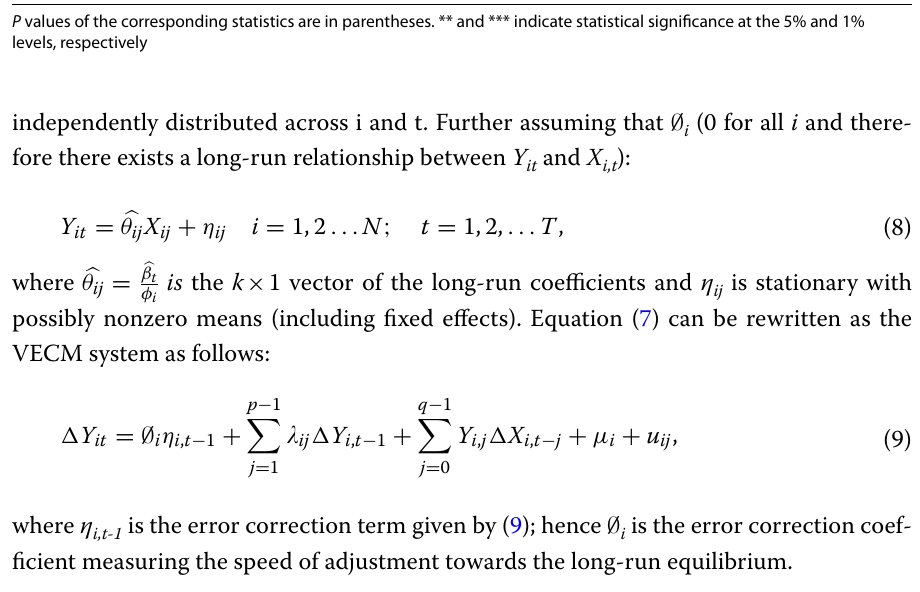
P values of the corresponding statistics are in parentheses. ** and *** indicate statistical significance at the 5% and 1% levels, respectively